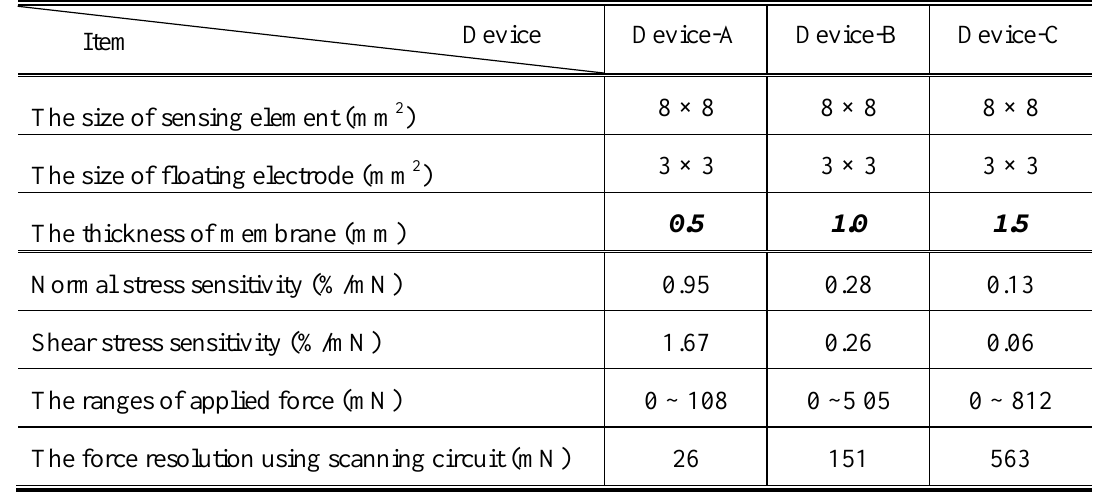
Table 1. The dimensions and performance characteristics of the fabricated shear sensing elements. Item